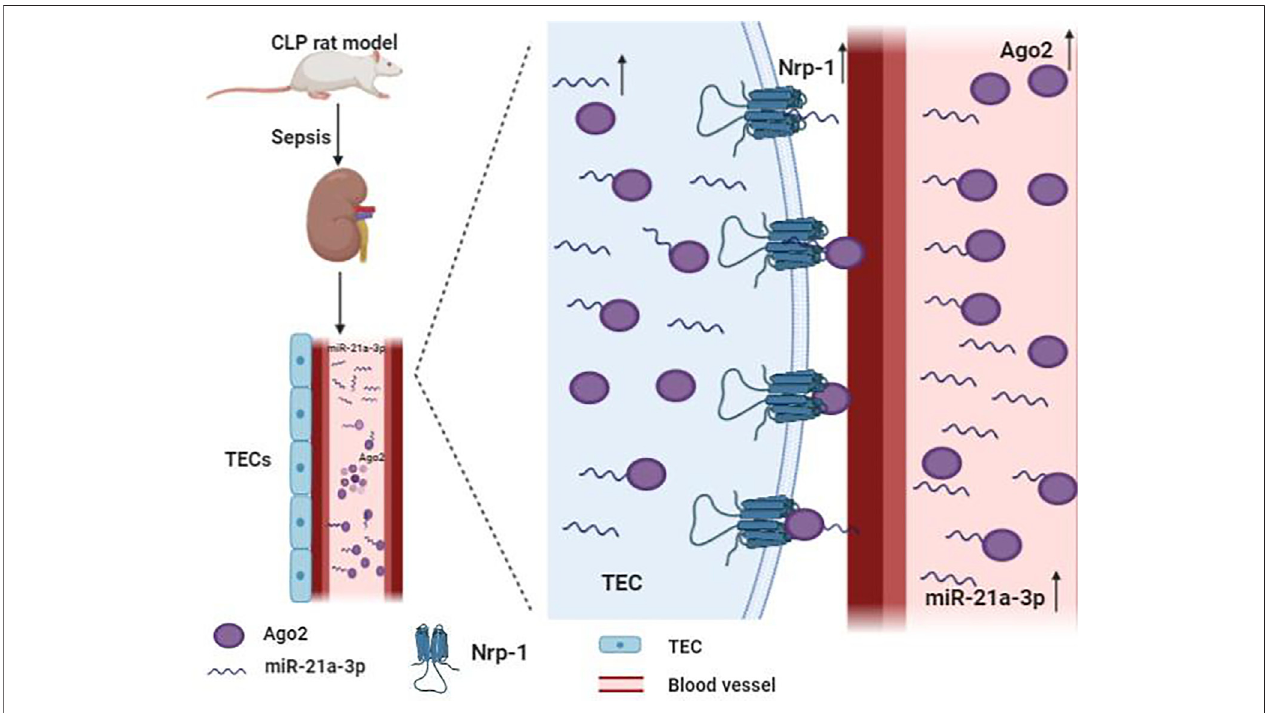
FIGURE2| MechanismoftheaccumulationofmiR-21a-3pintubularepithelialcells(TECs)duringsepsis.miR-21a-3pstablyexistsinbloodandurinebybindingto argonaute2 (ago2). Neurocorin-1 (Nrp-1) acts as cell “ cargo ” transporting extracellular molecules, such as miR-21a-3p and miR-21a-3p-ago2, into cells.